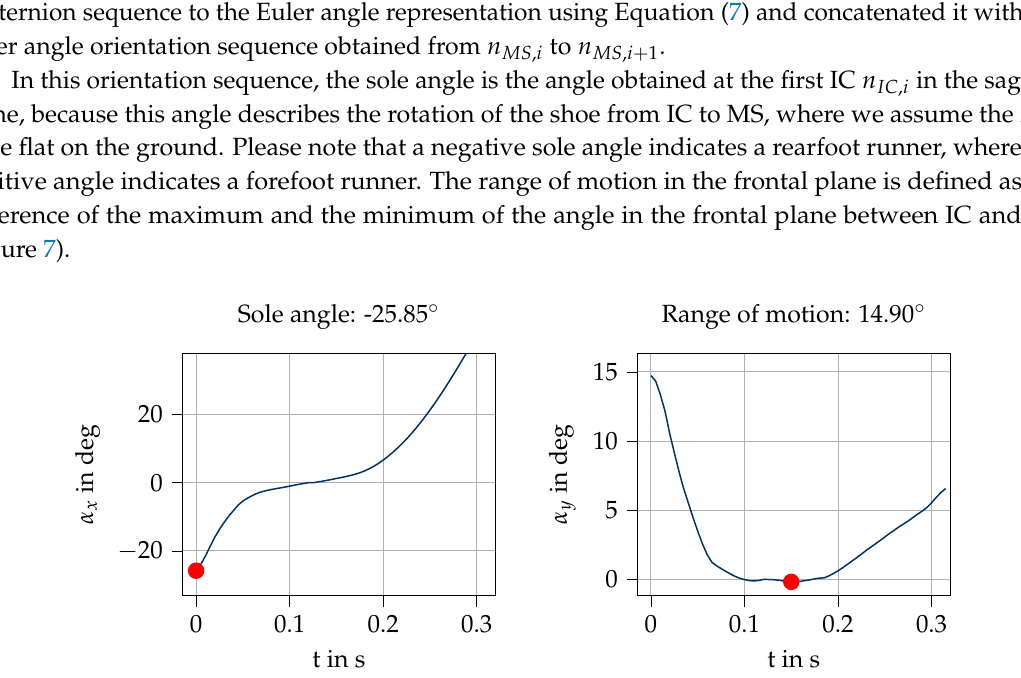
Figure 7. Visualization of angle computation for a sample stride from the cavity sensor. The angles are depicted from n IC ( t = 0s) to n TO ( t = 0.32s). The sole angle is defined as the rotation in the sagittal plane between IC and MS. As the orientation is initialized with zero at MS, the sole angle is the angle at n IC . The range of motion is defined as the difference between the maximum and minimum (red dots) of the angle in the frontal plane during ground